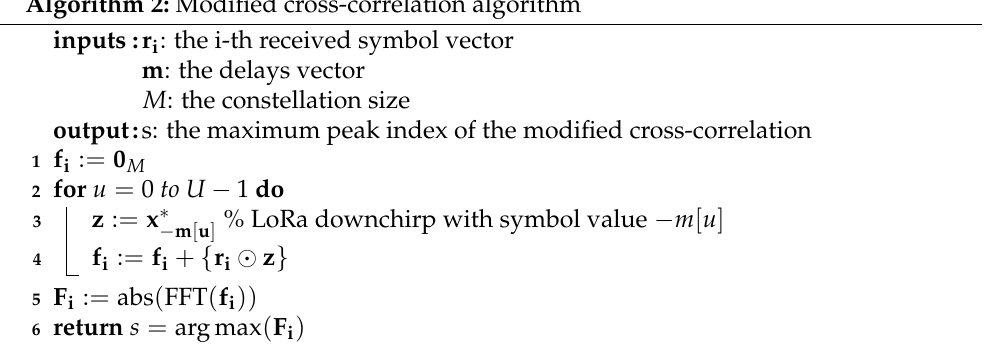
Algorithm 2: Modified cross-correlation algorithm